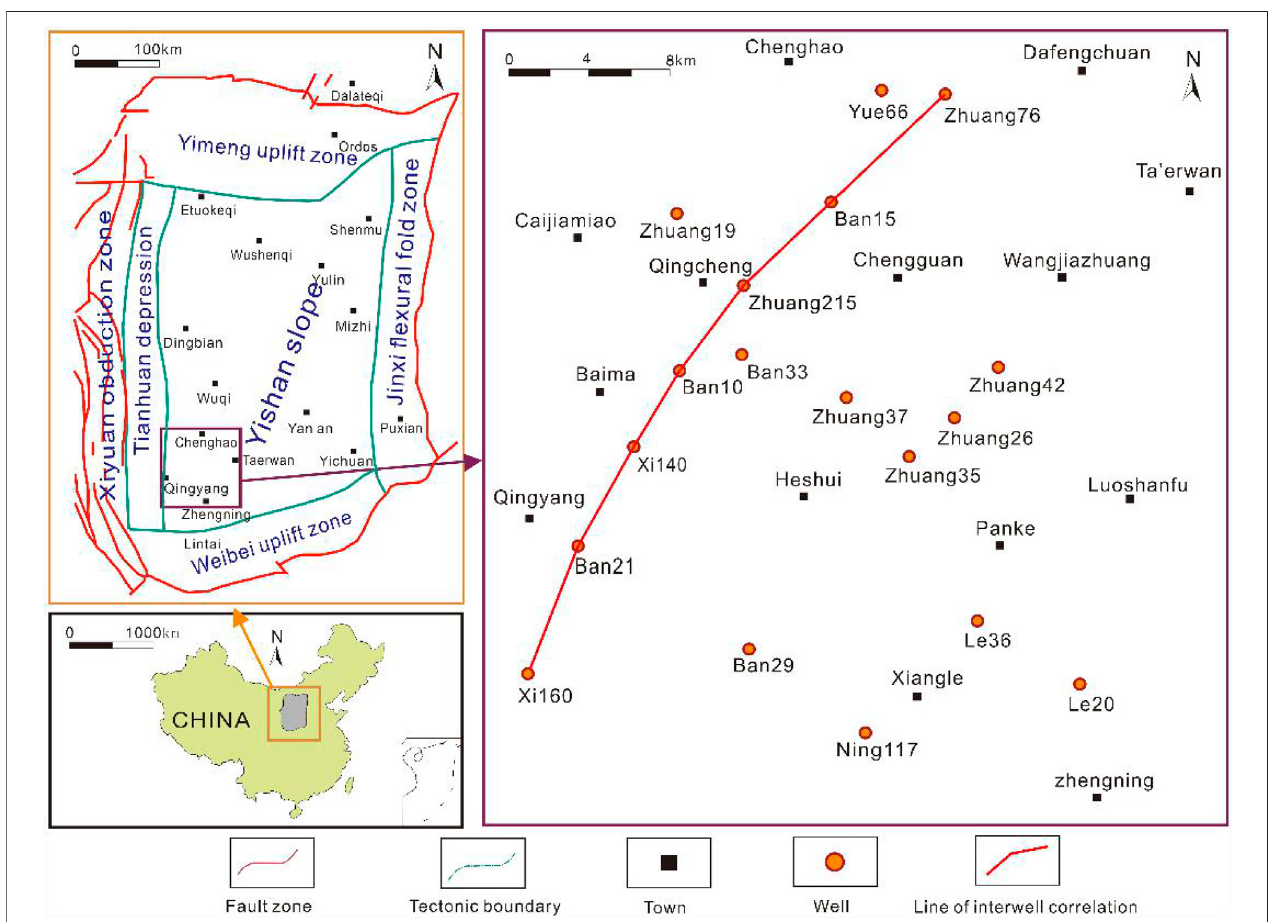
FIGURE 1 | Tectonic division of Ordos Basin and the location of the study area, connecting-well pro fi les, wells in this study, and the wells sampled therein.